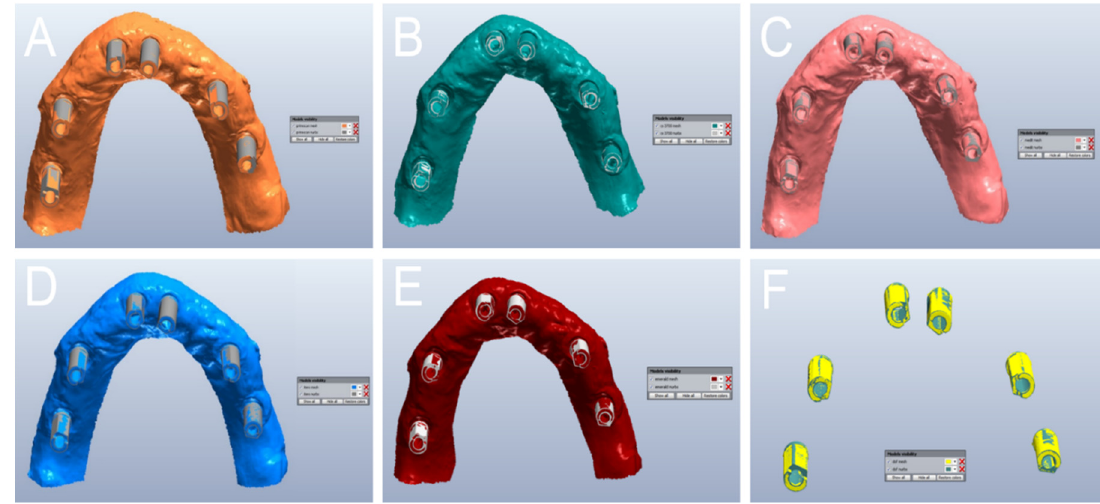
Figure 10. Qualitative evaluation of the deviation patterns (occlusal view of the model). ( A ) With PRIMESCAN ® , the SB meshes (MEs) were included inside the SB library files (LFs). ( B ) With CS 3700 ® , the SB LFs were included inside the SB MEs. ( C ) With MEDIT i-500 ® , a remarkable interpolation between the SB ME and the SB LF was seen, with no clear direction for the deviation. ( D ) With ITERO ELEMENTS 5D ® , the SB MEs were included inside the SB LFs. ( E ) With Emerald S ® , the SB MEs were included inside the SB LFs. ( F ) With DOF UHD ® , the SB LFs were included inside the SB MEs. Table 7. Distribution of the deviations in the different surfaces of the SBs, by visual inspection. Scanner Deviation Flat Central Flat Lateral Back Outward deviation + + + No deviation PRIMESCAN ®